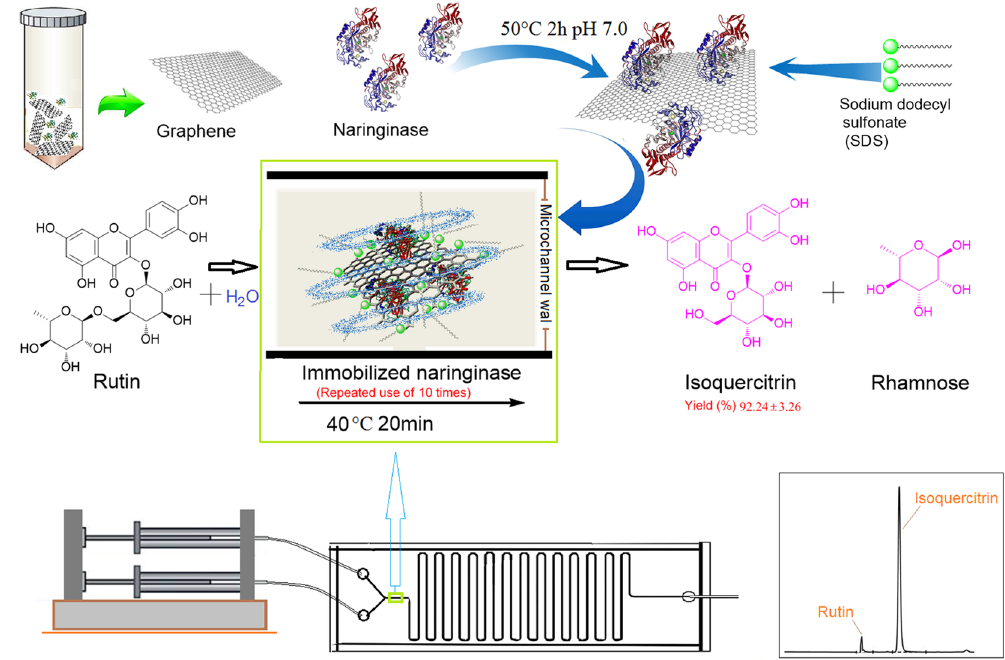
Figure 1. Biosynthesis diagram of isoquercitrin in a microchannel reactor with a fluid and unsinkable immobilized enzyme. The photos were taken and modified by C. Z., and the diagram was drawn by A.